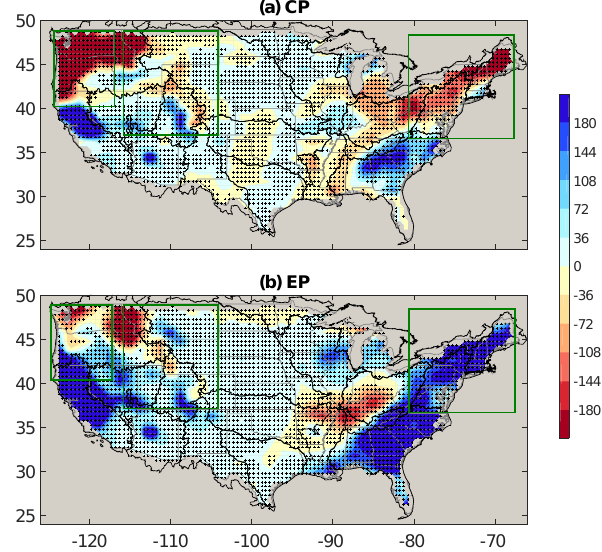
Figure 6. Same as Fig. 2, but using NCAR-CCSM4 model histori- cal output (unit: mm). + indicates results at 0.05 significance level based on a Monte Carlo test.